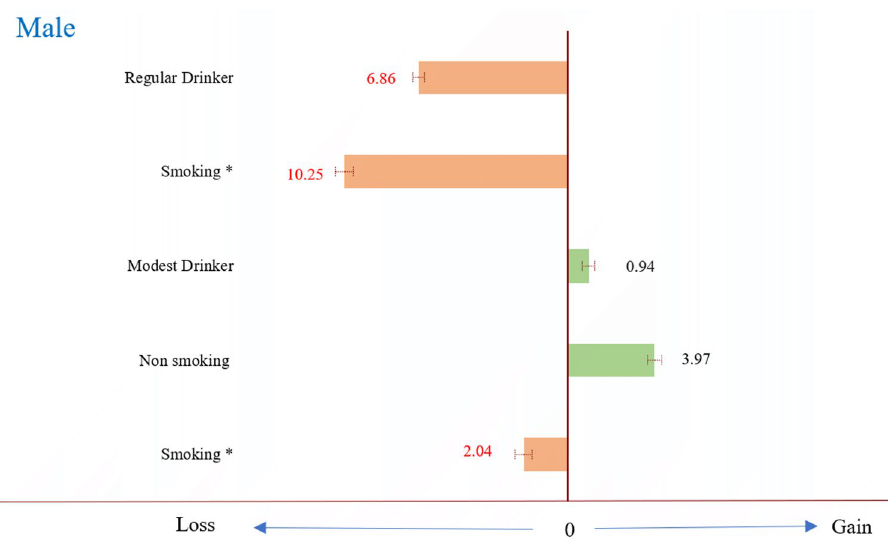
Figure 1. The difference in life expectancy among drinking status, compared to non-drinker. *Reference group is nonsmoking non-drinker. x-axis means the difference in life expectancy (years) among drinking status, compared to non-drinker. Regular Drinker include ex-drinker